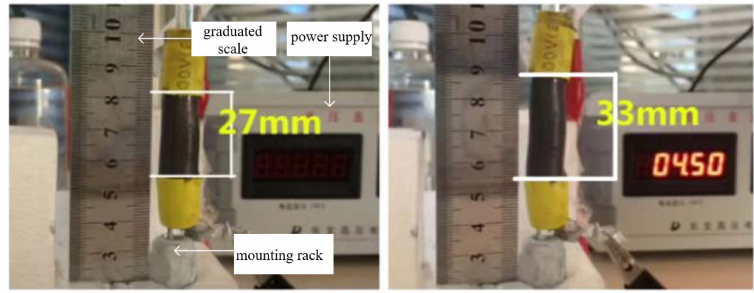
Figure 7. Actuating unit output displacement